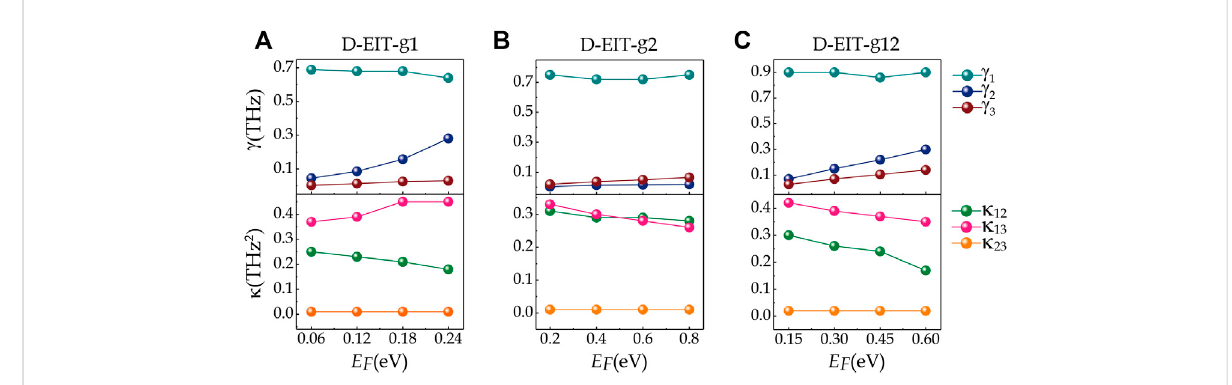
FIGURE 8 Theoretical fi tting values of the electromagnetic parameters γ 1 , γ 2 , γ 3 , κ 12 , κ 13 , and κ 23 under different E F for (A) D-EIT-g1, (B) D-EIT-g2, (C) D-EIT-g12.